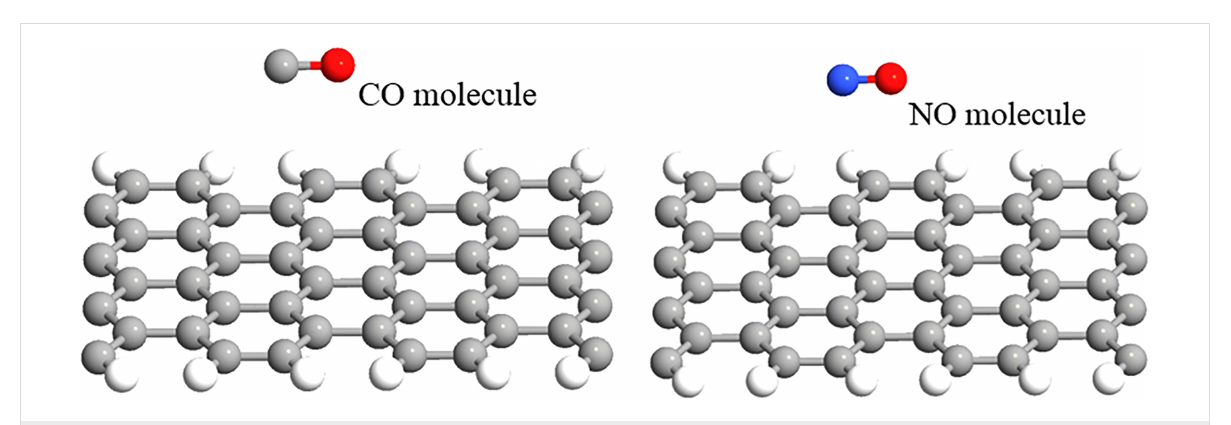
Figure 4: Orientation of CO and NO gas molecules on the 8-AGNR